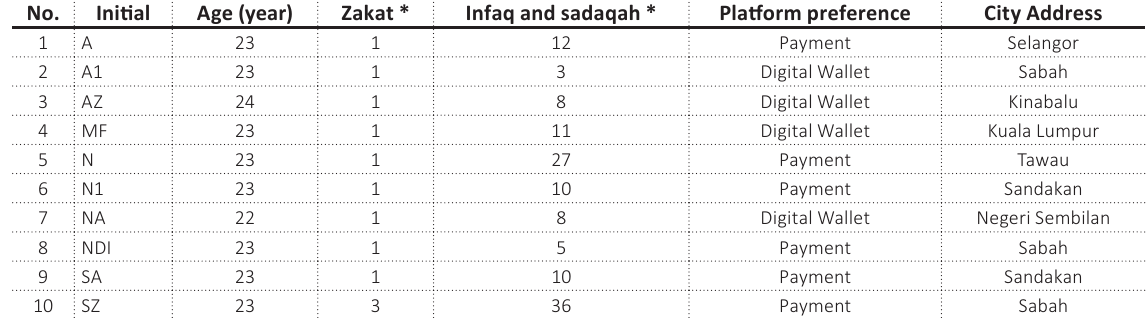
Note : * for the last three years (2018–2021). Table 2. Data of Malaysian participants